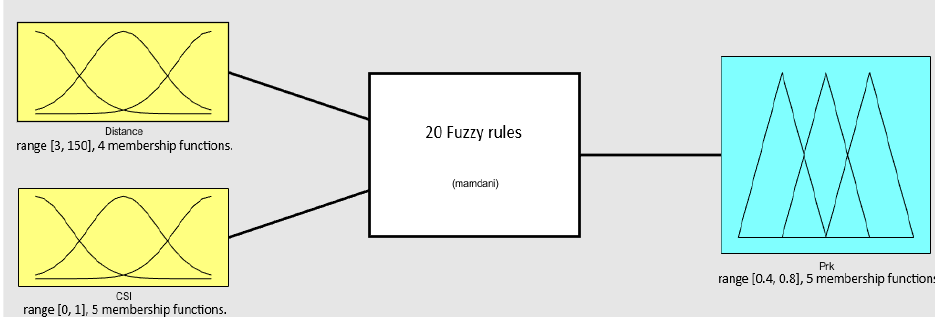
Figure 3. Proposed FIS structure.